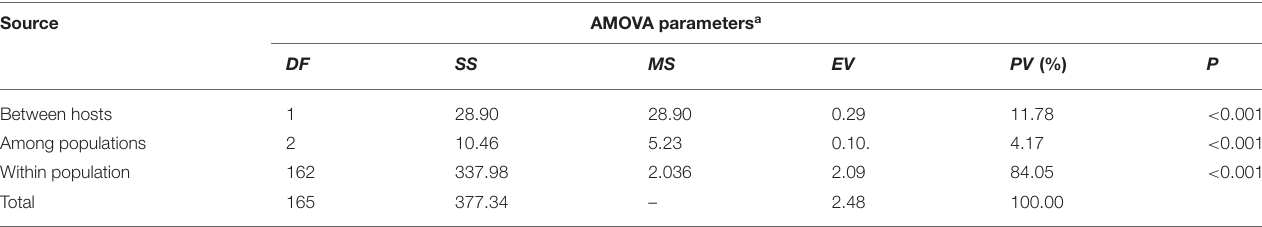
TABLE 2 | Analysis of molecular variance (AMOVA) among and within the Puccinia striiformis f. sp. tritici populations from barberry bushes and wheat plants based on the simple sequence repeat markers.